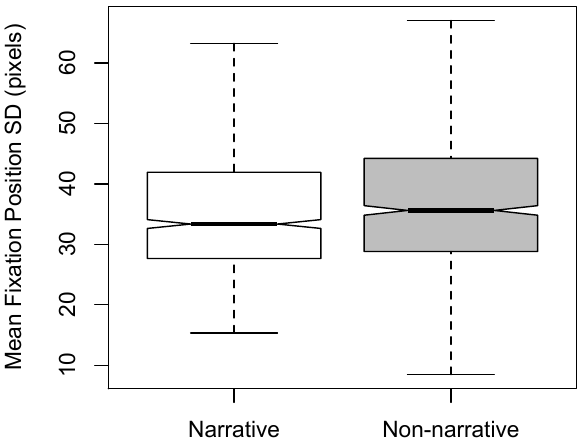
Figure 7. Notched boxplots of mean fixation position SD per time window for Dance-type (non-narrative and